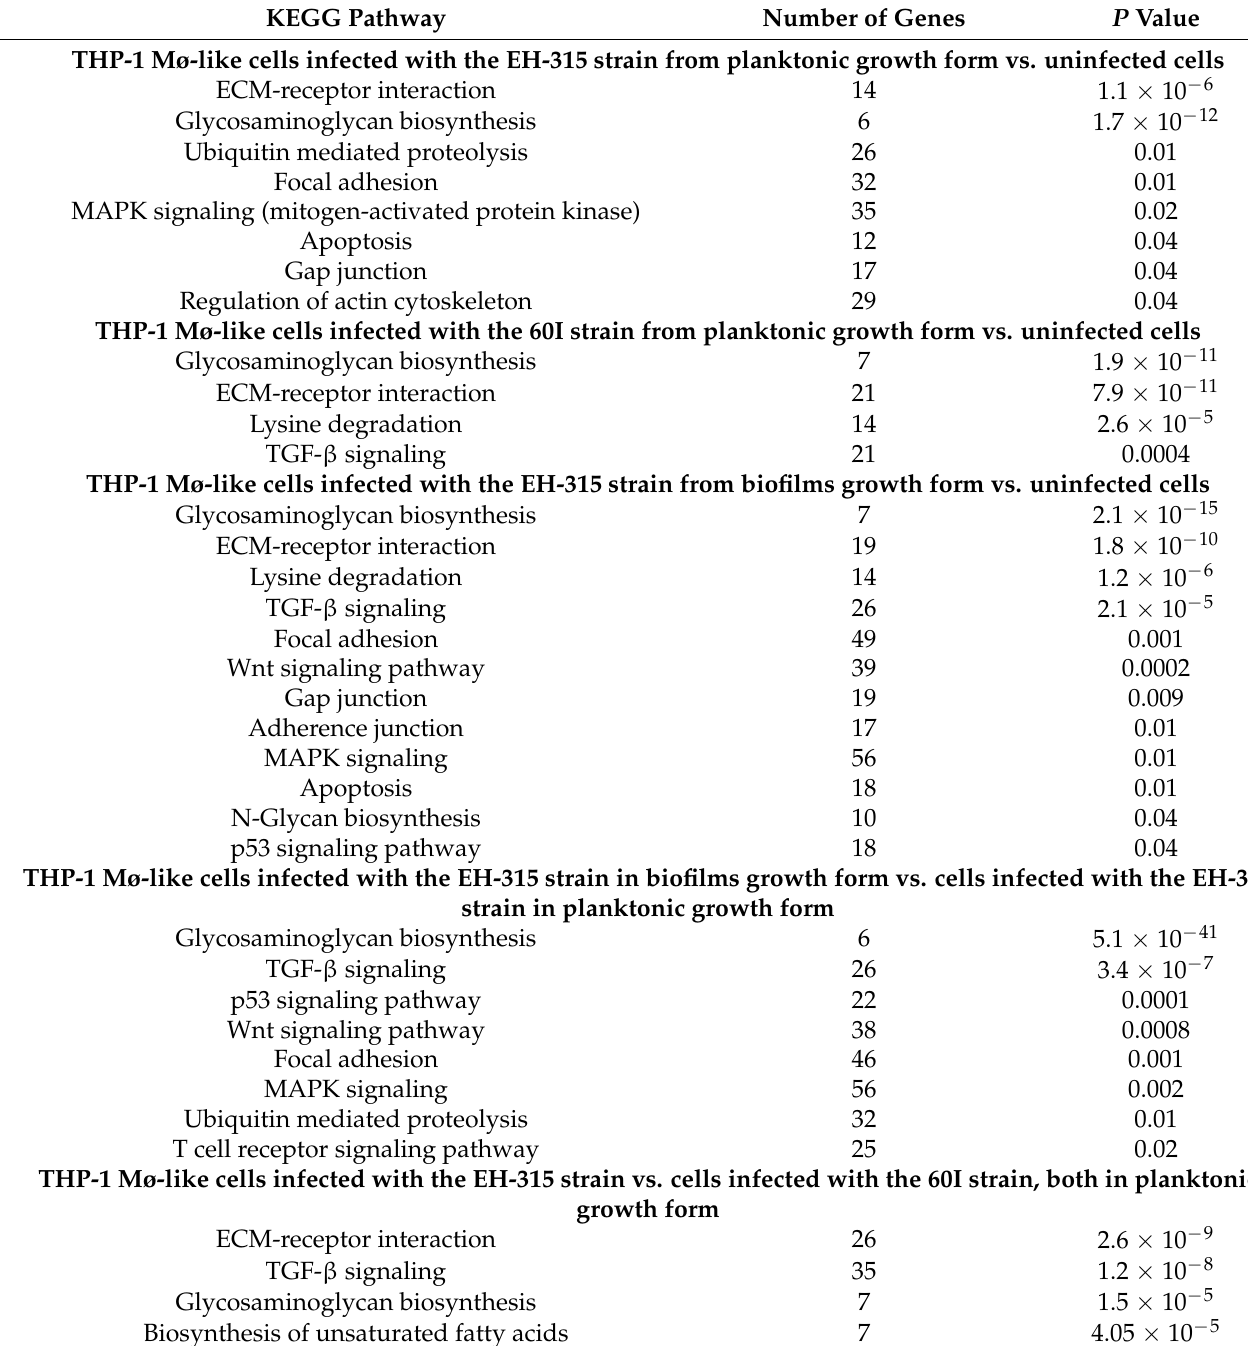
Table 2. Pathways associated with target genes regulated by differentially expressed miRNAs in Table 1. Mø-like cells in- fected with H. capsulatum . Data analyses used the miRPath 2.0 and MIRSystem software, along with the Kyoto Encyclopedia of Genes and Genomes (KEGG)